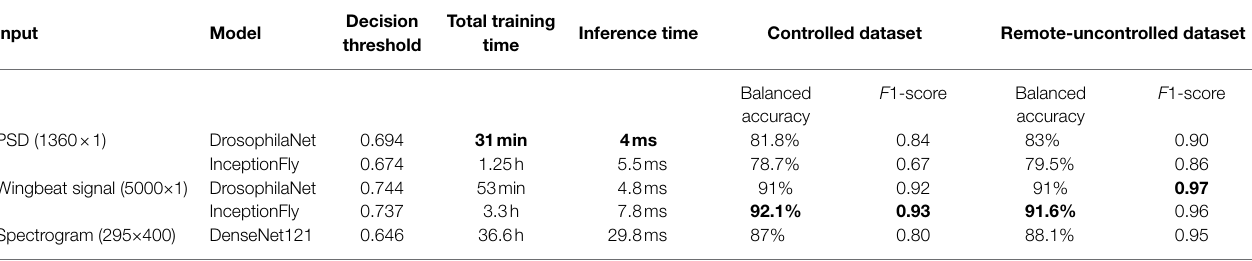
TABLE 2 | Model performance for selected data types on the two test datasets (controlled and